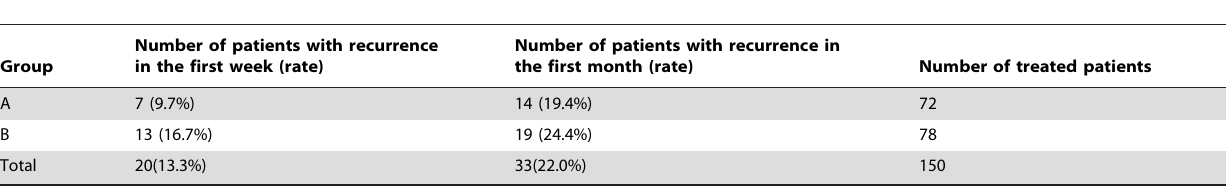
Table 1. The comparison of recurrence rates in patients who were with (group A) or without (group B) the instruction of postural restriction.